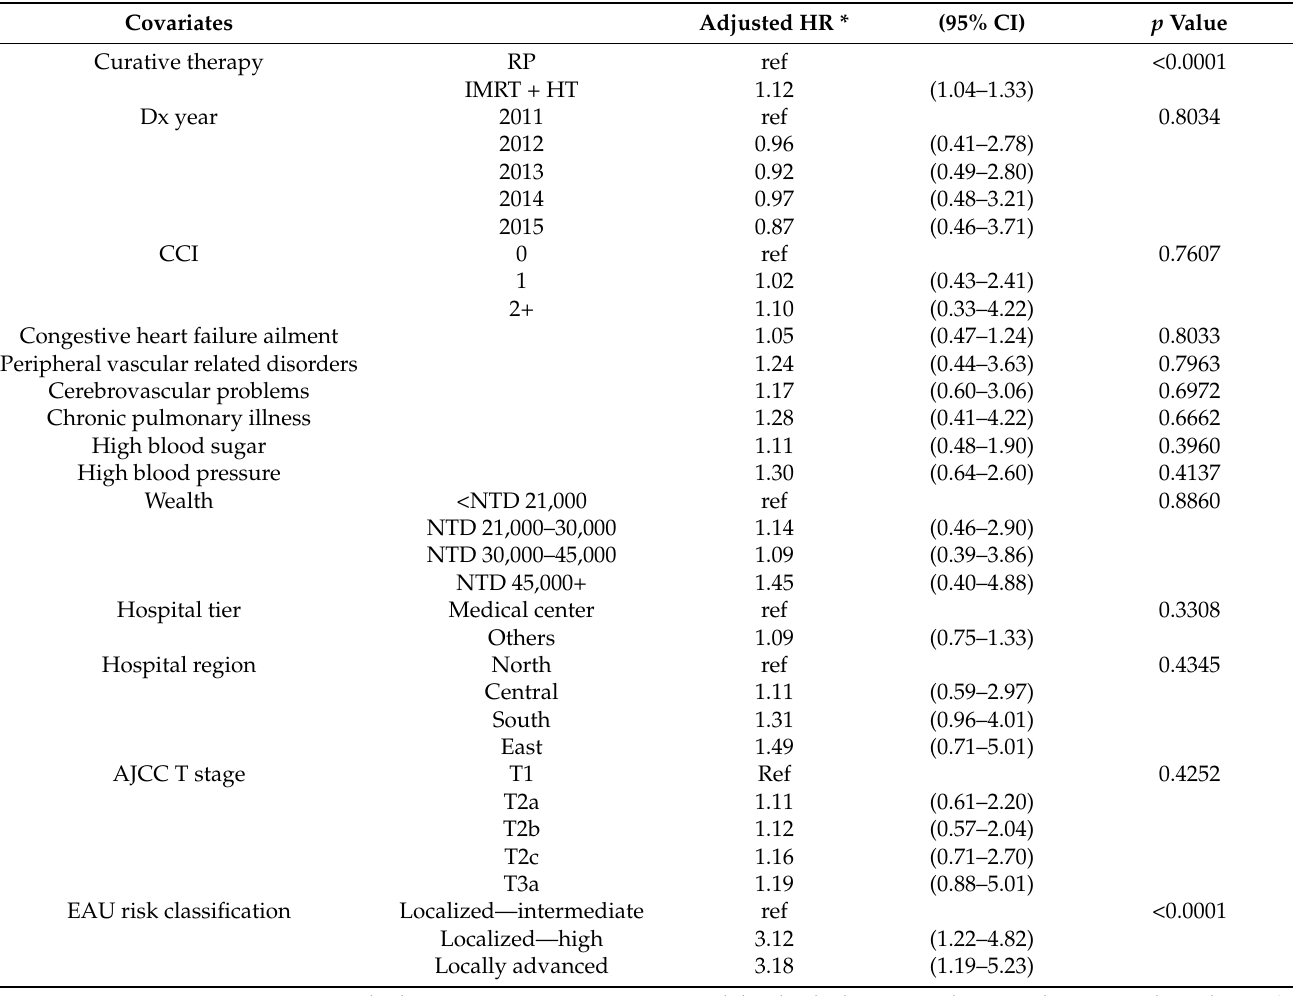
Table 3. The AV-LPC statistics of locoregional recurrence: Multivariate Cox regression model.